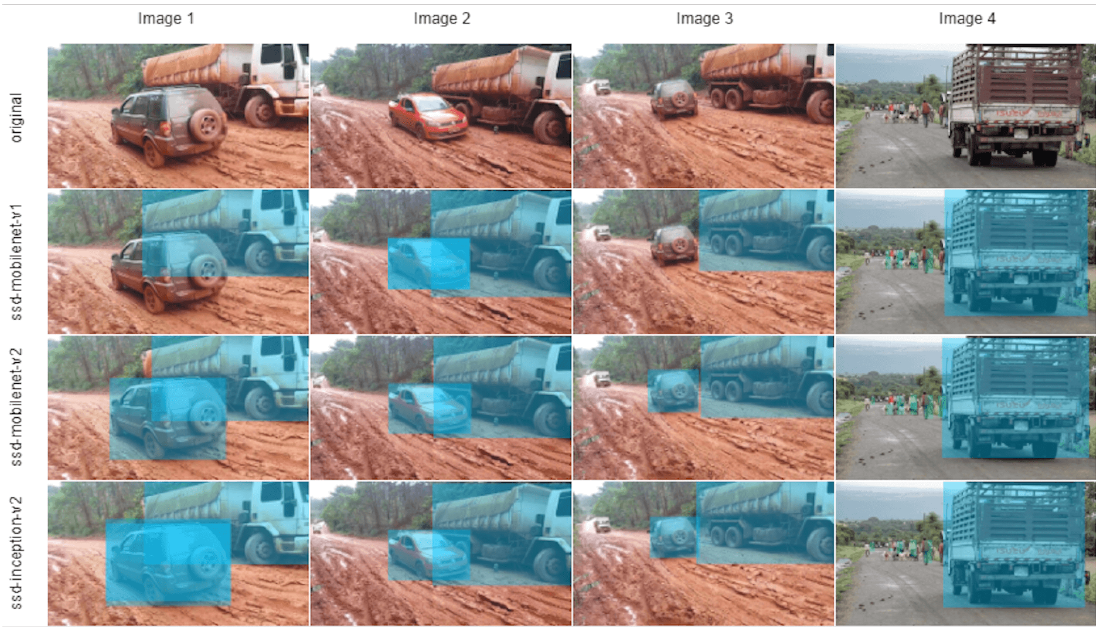
Figure 10. Results for the object detection of the vehicles in each of the three networks on four different test images. Blue boxes represent normal detections.